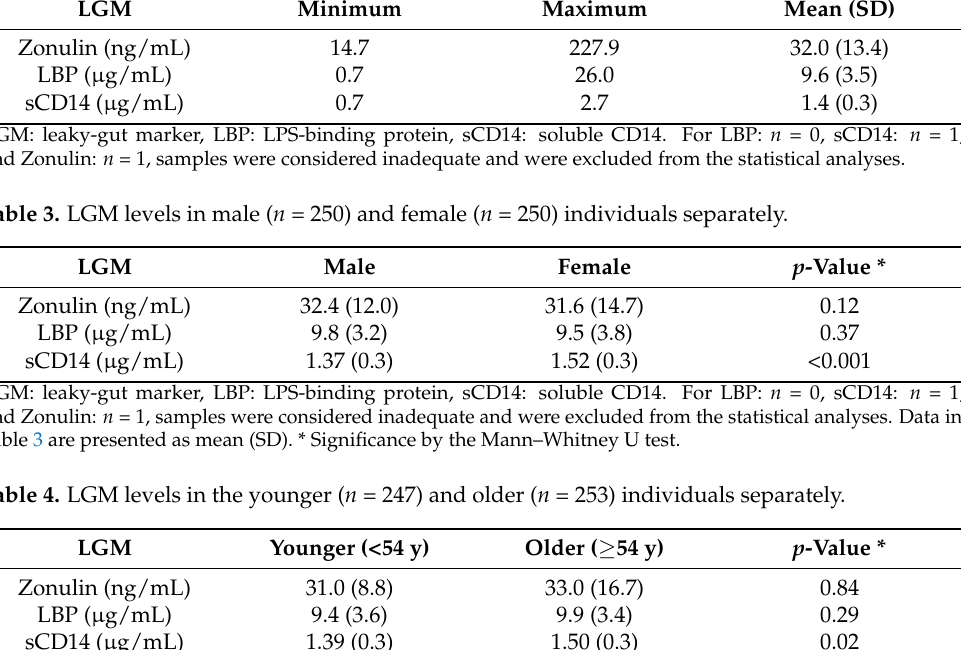
Table 2. LGM levels in the individuals selected from the NQplus study ( n = 500). LGM Minimum Maximum Mean (SD) Zonulin (ng/mL) 14.7 227.9